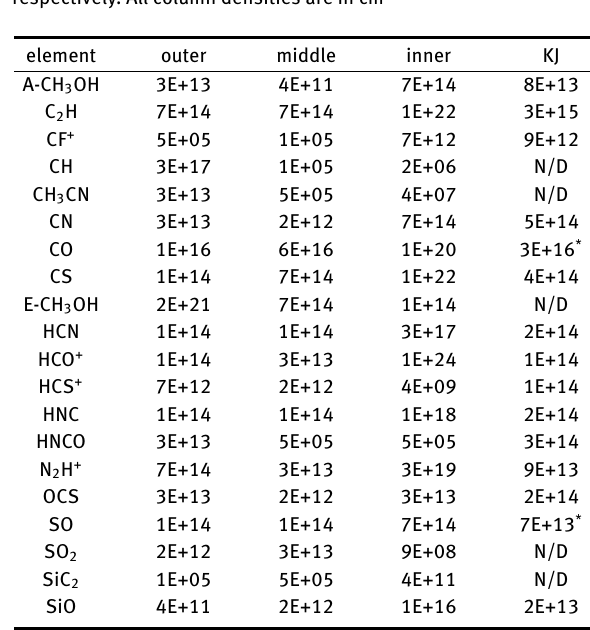
Figure 9. Fitting a modelled line to the CO transition at 115.27 GHz. Table 1. Overview of the estimated column densities for some species in the outer, middle and inner layer at 22K, 34K and